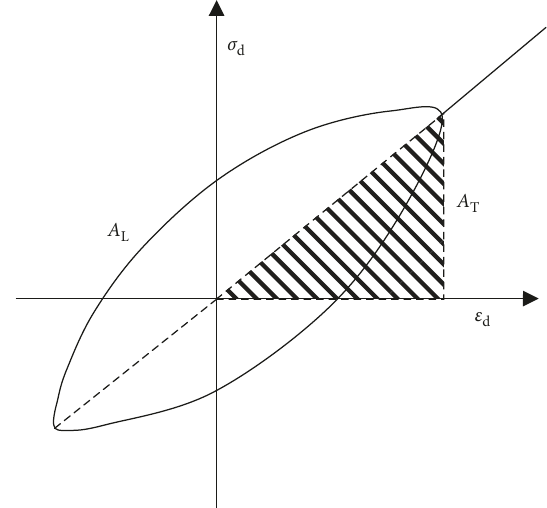
Figure 11: Definition of damping ratio.